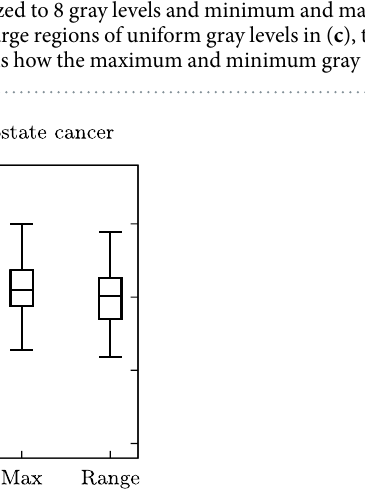
Figure 6. The span of ADC values in the data sets. Boxplots of ADC minimum and maximum values as well as the range of ADC values within each tumor for the glioma data set and the prostate cancer data set